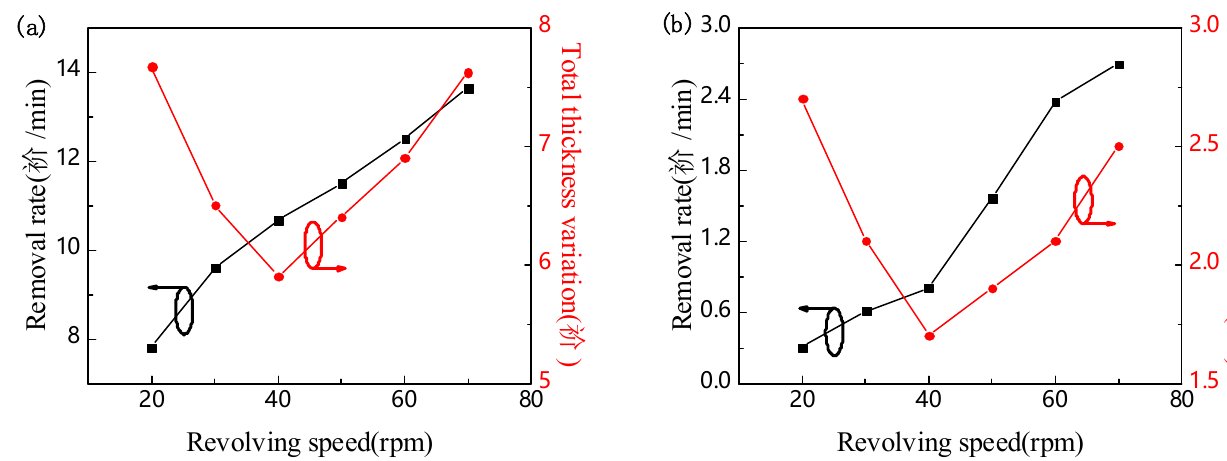
Figure 5. Removal rate and total thickness variation varied with revolving speed of ( a ) processing 1 and ( b ) processing 2. After the lapping process is completed, the damaged layer on the wafer surface needs to be removed by a chemical mechanical polishing process [34–36]. Amorphous silica with an abrasive grain size of 50 nm was used for polishing. During the polishing process, the polishing liquid drops on a part of the polishing disc. The centrifugal force caused by the rotation of the polishing disc will evenly distribute the polishing liquid on the surface of the running disc. The polishing liquid is mainly composed of chemical substances and abrasive grains. Chemical substances have a chemical interaction with the polished surface, and abrasive grains have a mechanical (physical) interaction with the polished surface. As shown in Figure 6a, when the rotating speed of the polishing disc is 70 r/min, the wafer surface roughness of the LiNbO 3 wafer first decreases and then slowly increases with the increase of the slurry flow rate. When the slurry flow rate